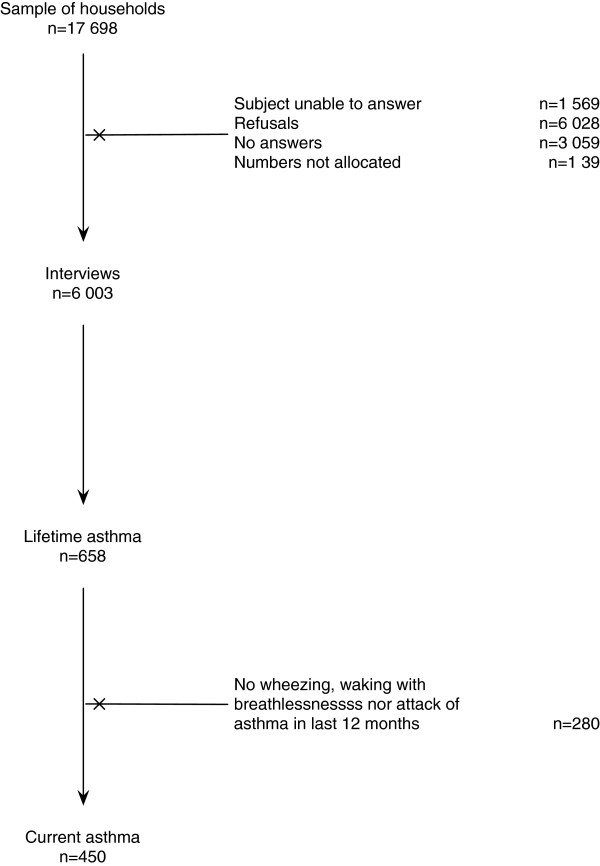
Participants flowchart. From the 17 698 households contacts, 6 003 participants were included in the study; 658 classified as having ‘Lifetime asthma’ and 450 as having ‘Current asthma’.